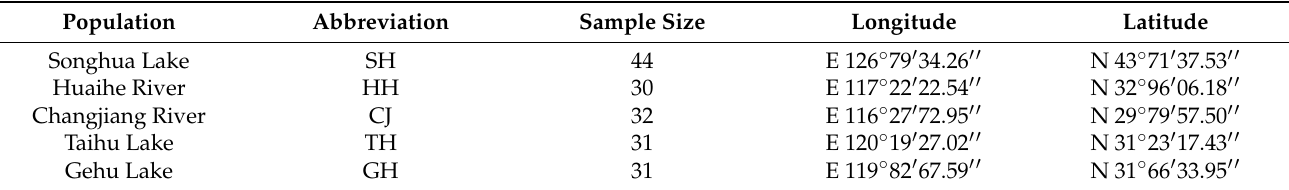
Table 1. Sampling information of C. alburnus in five different river